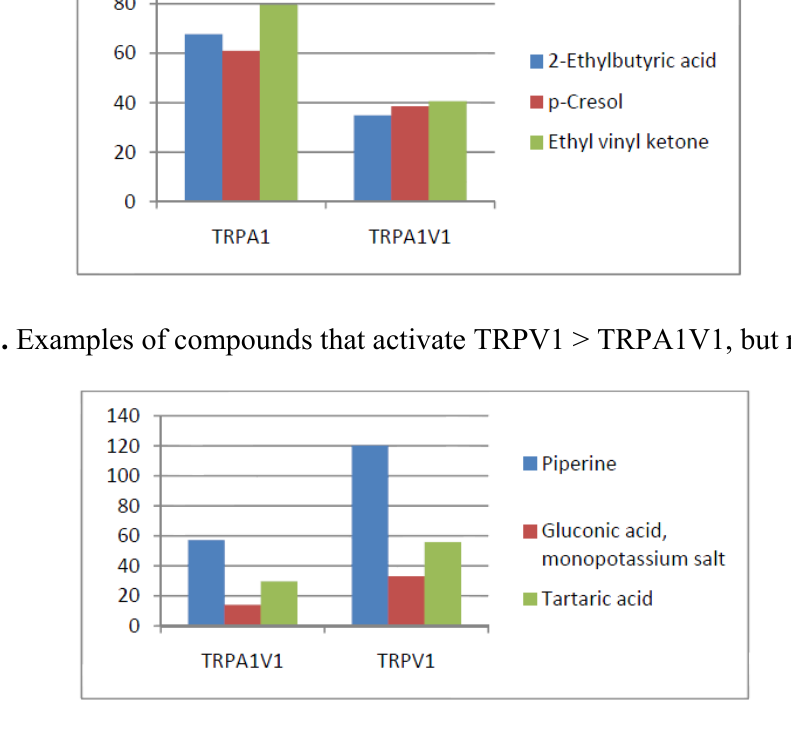
Figure 9. Examples of compounds that activate TRPA1 < TRPA1V1, but not TRPV1.